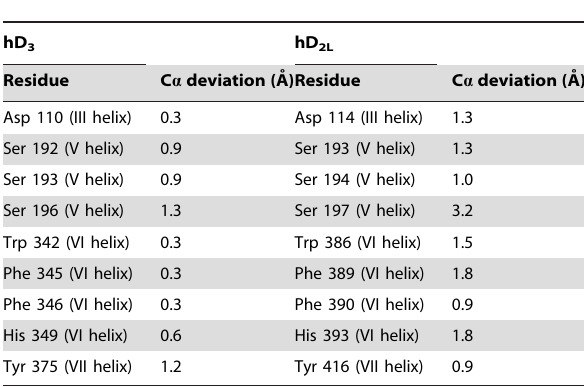
Table 1. Deviations of C a of residues belonging to the orthosteric binding pocket of optimized receptors in comparison with the starting